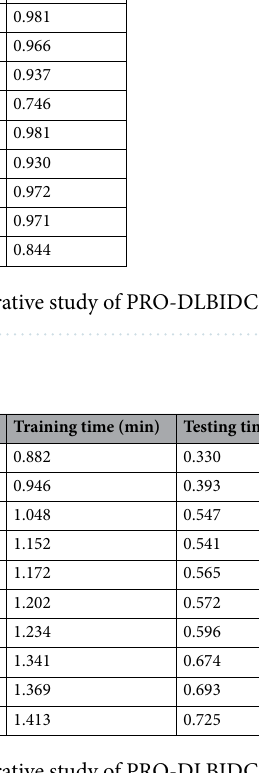
Table 3. Comparative study of PRO-DLBIDCPS technique in terms of TST and TGT.